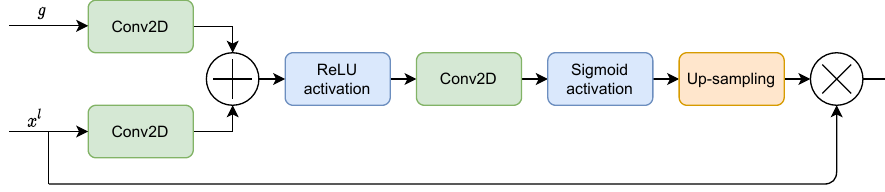
Figure 12. Structure of the AG proposed by Oktay et al. [46].